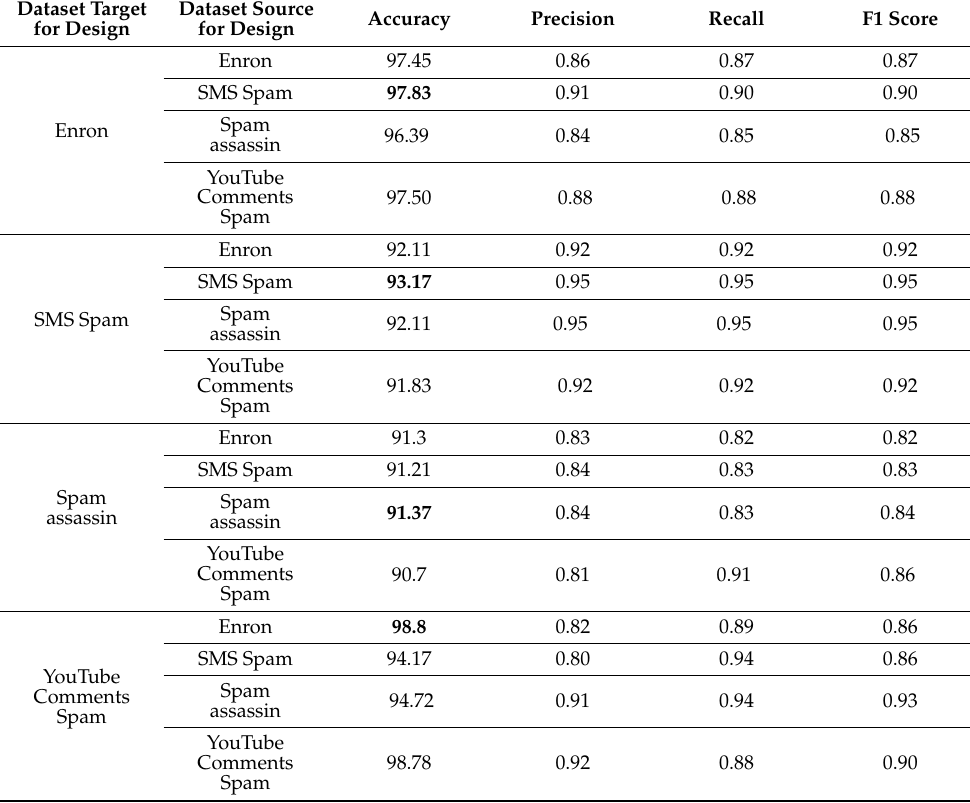
Table 13. Results of running the SPHH with transfer learning for the spam detection datasets.